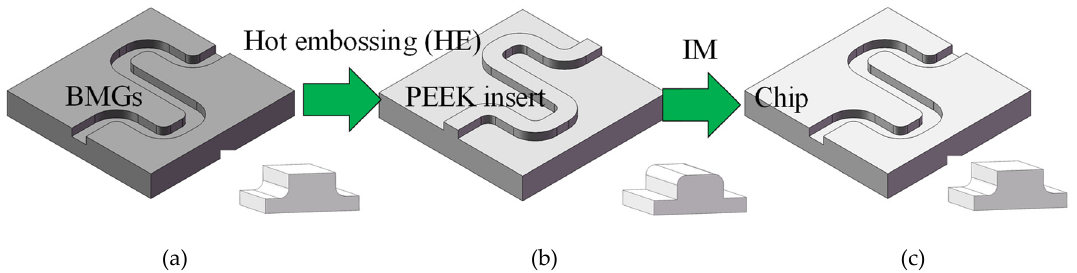
Figure 18. The optimized process for fabricating a microstructure on the chip. ( a ) The micro milled mold; ( b ) the PEEK insert; ( c ) the obtained microstructure.